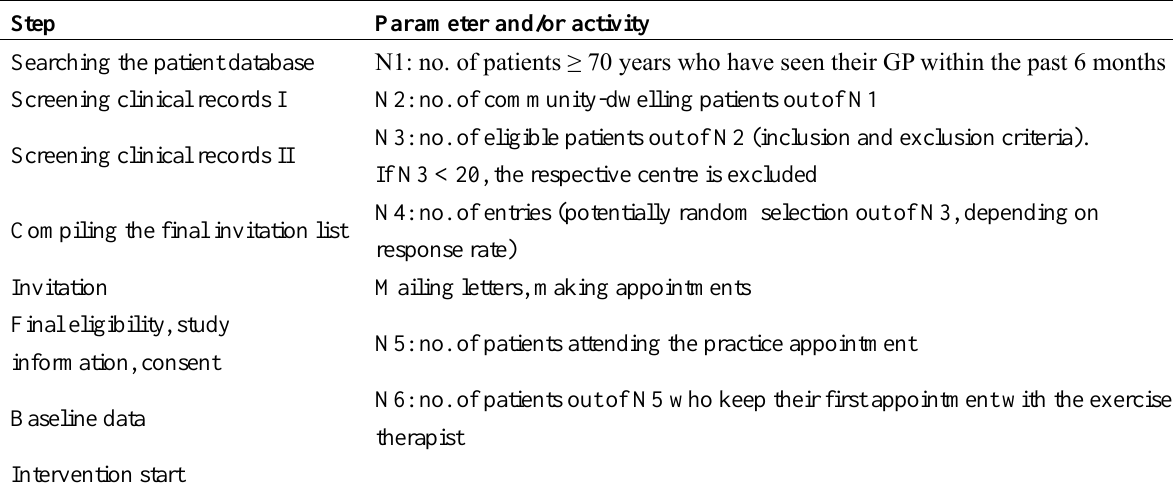
Table 1. Recruitment steps and